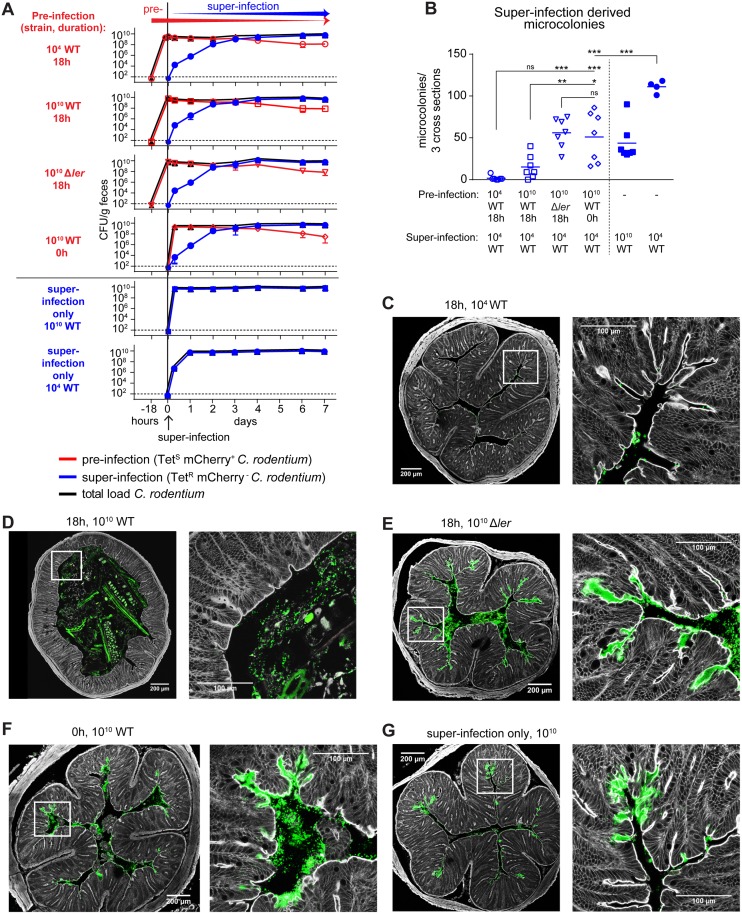
An early window of opportunity for A/E microcolony induction in wild-type mice.(A) Colonic luminal colonization trajectories of the pre-infection strain (red open symbols: circles, 104 CFU Wild type C. rodentium [WT]; squares, 1010 CFU WT; inverted triangles; 1010 CFU Δler mutant), the super-infection strain (blue filled symbols: circles, 104 CFU WT; squares, 1010 CFU WT), and total bacteria (pre-infection + super-infection strain; black triangles). Connecting lines connect means; error bars indicate standard deviations. Horizontal dotted lines indicate the lower detection limit. (B) Microcolony formation of superinfection strain after 7 days. N = 6–7 per group, pooled from 3 independent experiments. (C-G) Representative confocal fluorescent microscopy images of distal colon of mice shown in panel B. Grey, F-actin/phalloidin; green, anti-O-antigen Antibody (C. rodentium total); red, mCherry-expressing C. rodentium (pre-infection strain only); Scale bars: 200 μm and 100 μm as indicated; White squares indicate origin of higher-magnification image; *, p < 0.05; **, p < 0.01; ***, P < 0.001; ns, not significant (p ≥ 0.05); statistical test: one-way ANOVA.